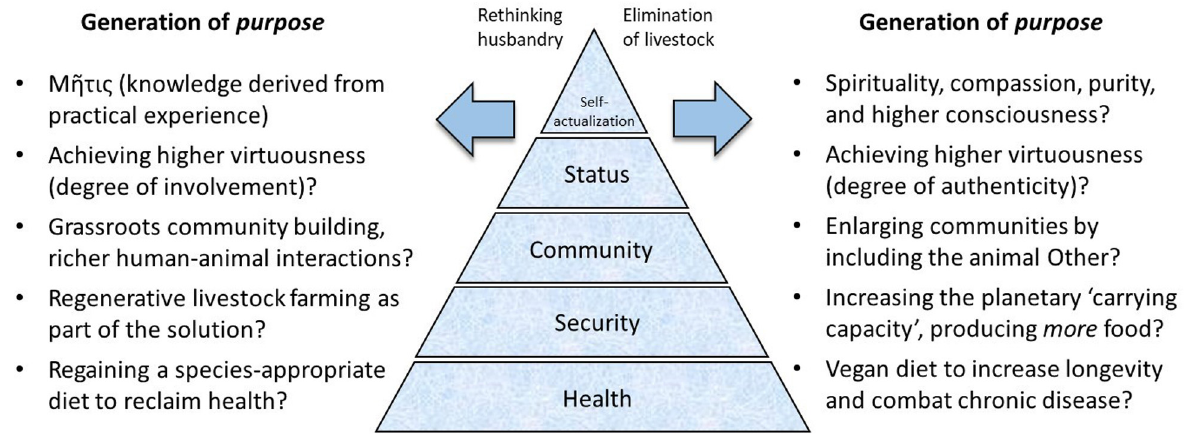
FIGURE 2 | Fulfillment of biosocial needs through reimagined human-animal interactions, according to two potential scenarios for future foodscapes and